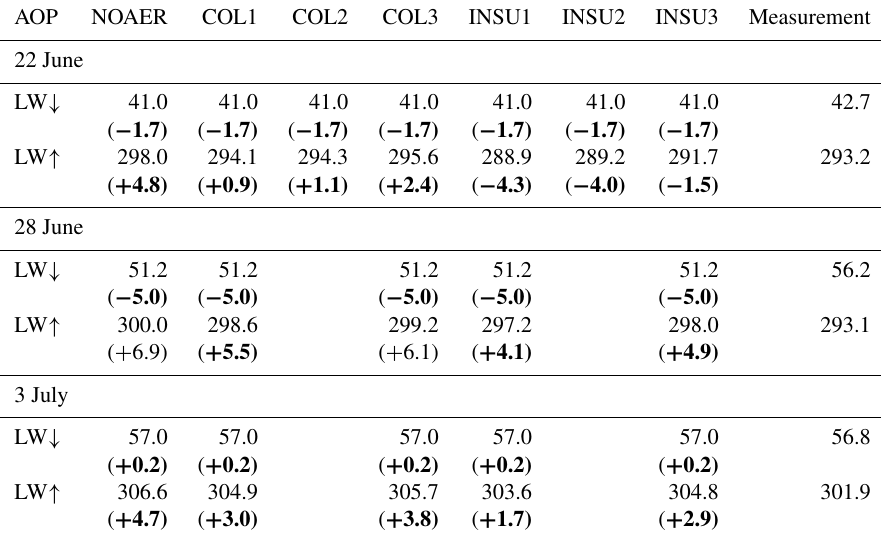
Table 5. Downward and upward LW irradiances measured on-board the Falcon 20 and modelled for on the three analysed cases. Model calculations are made with different AOPs. The measurements uncertainty is ± 6Wm − 2 . Differences with respect to measurements are shown in parentheses and are in bold if lower than the measurement uncertainty.